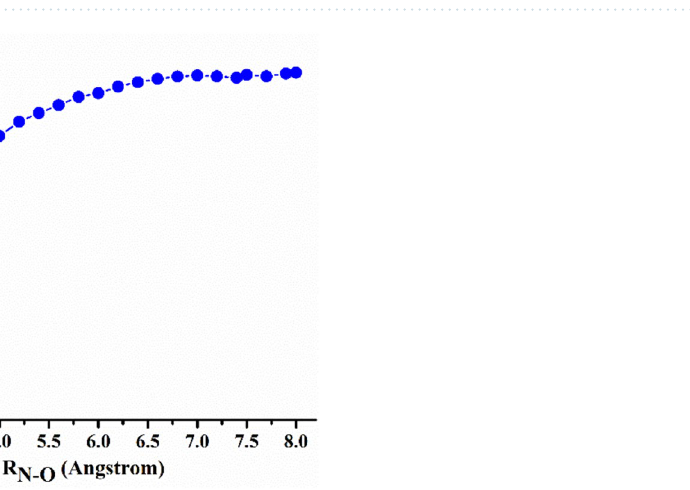
Figure 2. The stationary points on the PES for CH 2 NH + H 2 O + H 2 O reaction were obtained using CCSD(T)/6– 311++G(3df,3pd)//M06-2X/6–311++G(3df,3pd). The relative energies include ZPE corrections are relative to CH 2 NH + 2H 2 O.